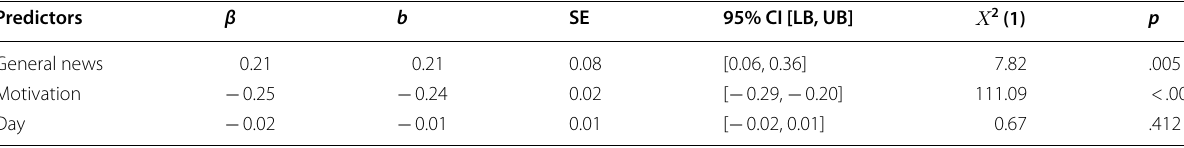
Note Rows present the effect of predictors on ratings of TUT (task-unrelated thought, 1 included News (general news consumption, no news consumption as the reference category), task motivation (1 and day (day-in-study from 1 to 10). The model also included a random effect of participant on the intercept. Analysis of variances was tested through Type III Wald chi-square tests. Residuals passed assumptions of normality and homogeneity of variance β standardized parameter, b unstandardized parameter, SE standard error of the estimate. 95% CI 95% confidence interval associated with the unstandardized parameter, UB upper bound, LB lower bound, Χ 2 (1) chi-squared test statistic associated with comparison between the current model and a null model without the predictor of interest (1 degree of freedom), p p -value associated with the chi-squared test